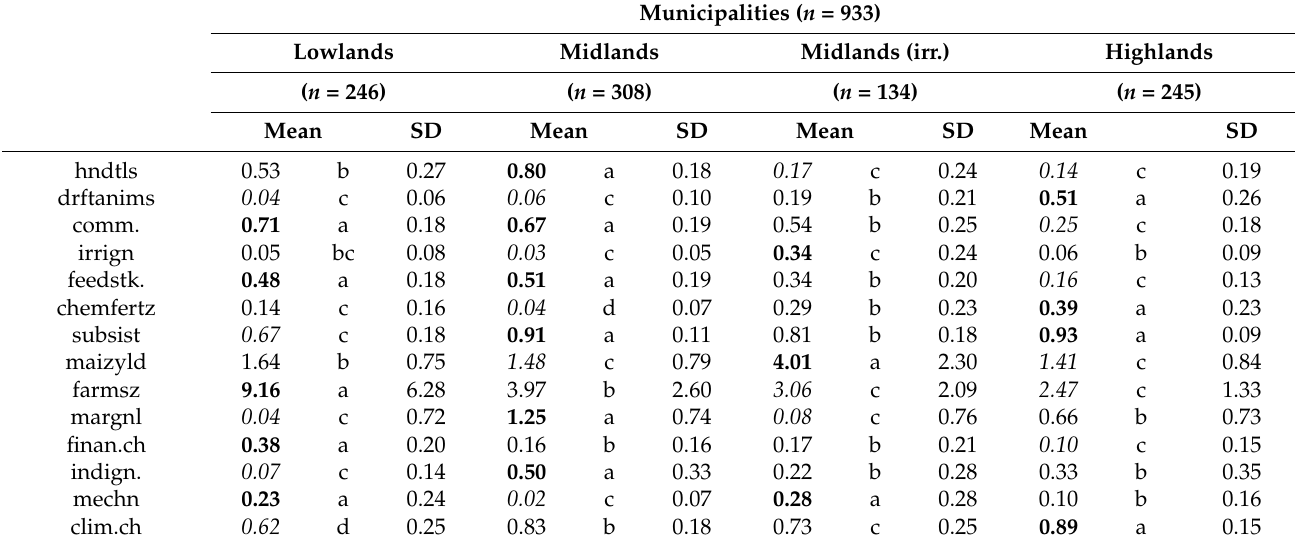
Table 2. Farm characteristics of municipalities in the study area stratified by farm type. Highest means appear in boldface and lowest means appear italicized. Letters (a,b,c,d) for significant differences were determined using ANOVA and Tukey post-hoc tests (normal distribution, homogenous variance), Kruskal–Wallis and Dunn’s post-hoc tests (non-parametric), and Pearson’s Chi-squared tests (proportional) ( α =